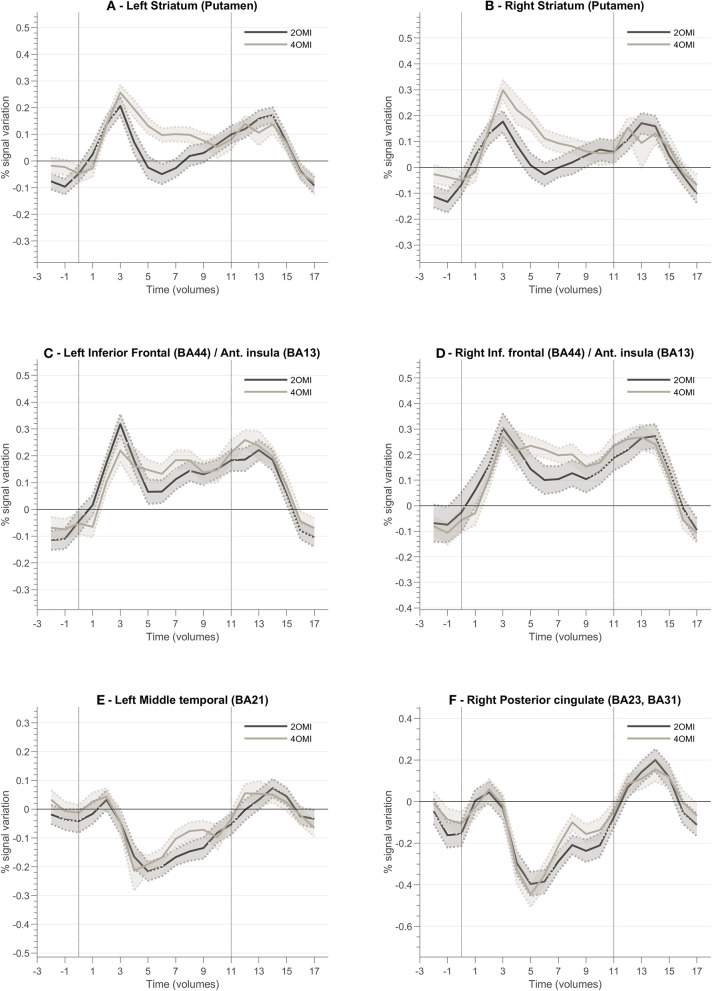
Block-related responses averaged across all participants for different ROI involved in the neurofeedback task and identified based on ANOVA 3-level within-subject factor analysis. Each plot presents the block-related curve for the conditions 2OMI and 4OMI for the following ROIs: (A) Left Striatum (Putamen); (B) Right Striatum (Putamen); (C) Left Inferior Frontal Cortex (Brodmann Area, BA, 44)/Anterior Insula (BA13); (D) Right Inferior Frontal Cortex (BA44)/Right Anterior Insula (BA13); (E) Left Middle Temporal Cortex (BA21); (F) Right Posterior Cingulate Cortex (BA23, BA31).